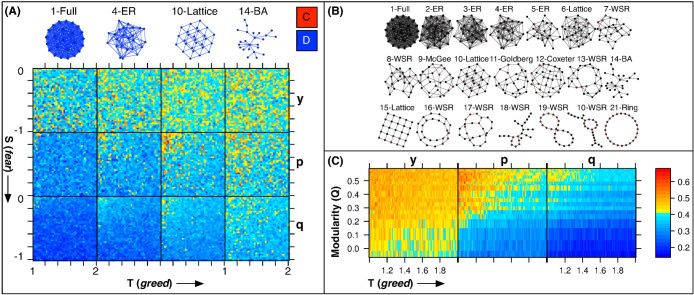
ST-Plane Network Comparison Results.Panel (A) shows a set of 4 × 3 cooperation images of ST-planes covered by equation (3) from a representative 4-structure subset of the 21 structures tested, rows are ordered top to bottom , , and  respectively, columns are ordered left to right from the 1-Full structure to 14-BA. Each image pixel represents the median cooperation level at coordinates (T, S) for its respective structure (column) and component (row). Panel (B) is comprised of 21 panels (sorted from low to high average path length), one for each network structure in this work. Panel (C) shows average cooperation of each component for all S as a function of modularity (Q) vertically versus temptation to defect T horizontally.